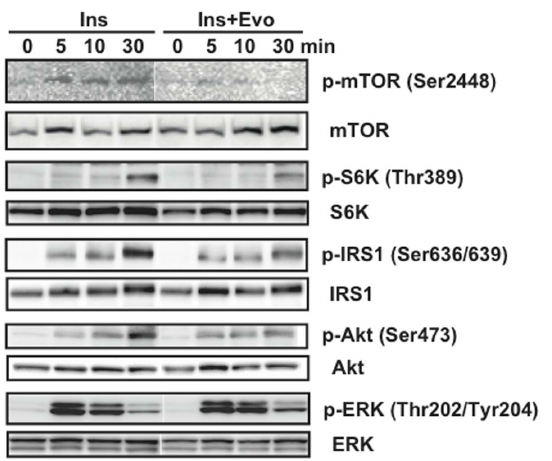
Figure 6. Effect of evodiamine on the insulin-stimulated activation of mTOR-S6K signaling in differentiated adipocytes. After 3T3-L1 pre-adipocytes were differentiated into mature adipocytes, the cells were maintained in DMEM for 4 h and then stimulated by 20 nM insulin with or without 20 m M evodiamine for the indicated length of time. The cell lysates (15–30 m g protein) were analyzed for phosphorylation of mTOR Ser2448, S6K Thr389, IRS1 Ser636/639, Akt Ser473 and ERK Thr202/Tyr204 by Western blot analysis. Representative images of two independent experiments are shown.